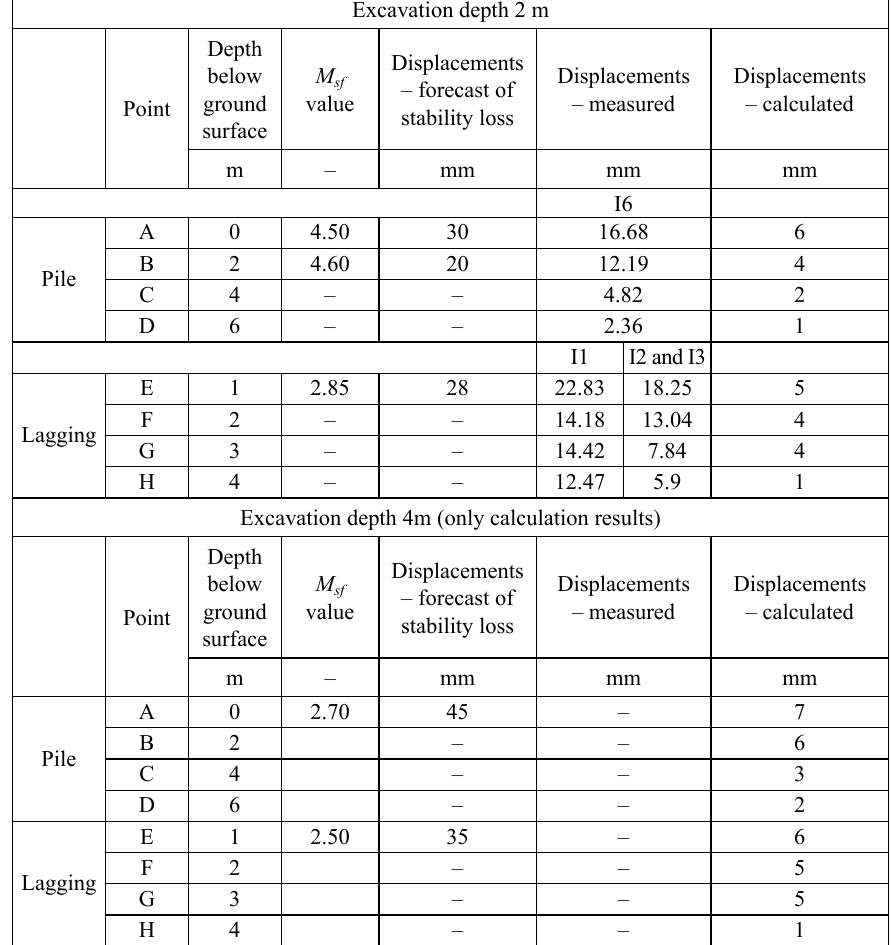
Table 4. Point location and its safety factor values Excavation depth 2